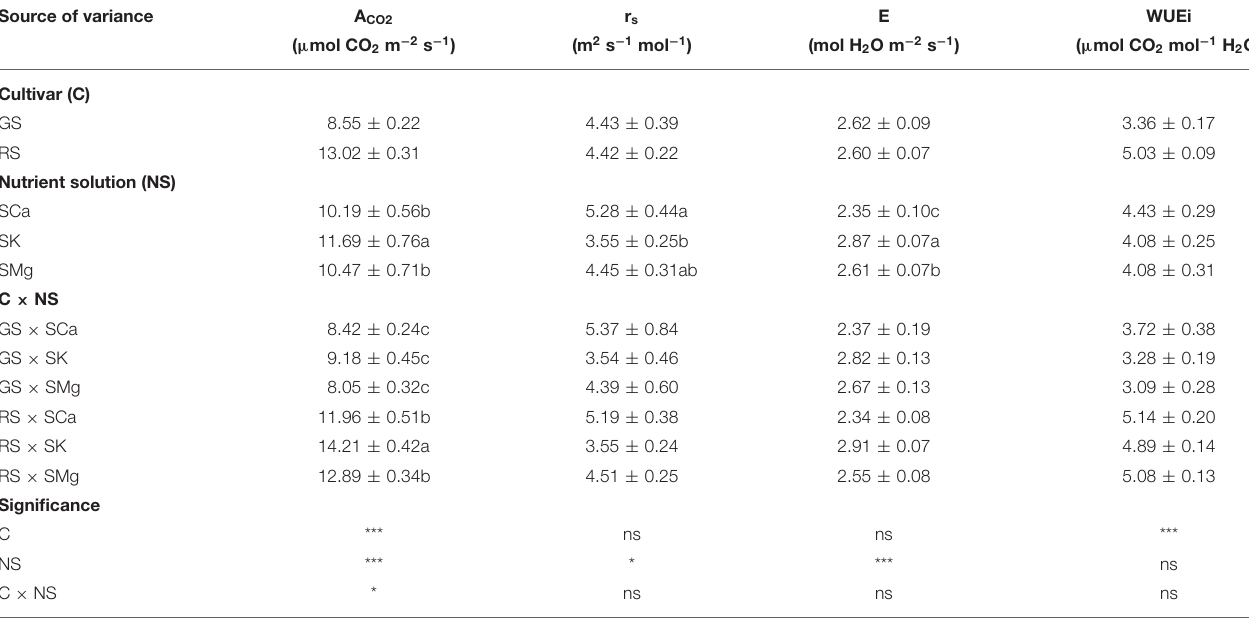
TABLE 4 | Effects of the C and of the NS on chlorophyll and gas exchange parameters of the leaves. Source of variance